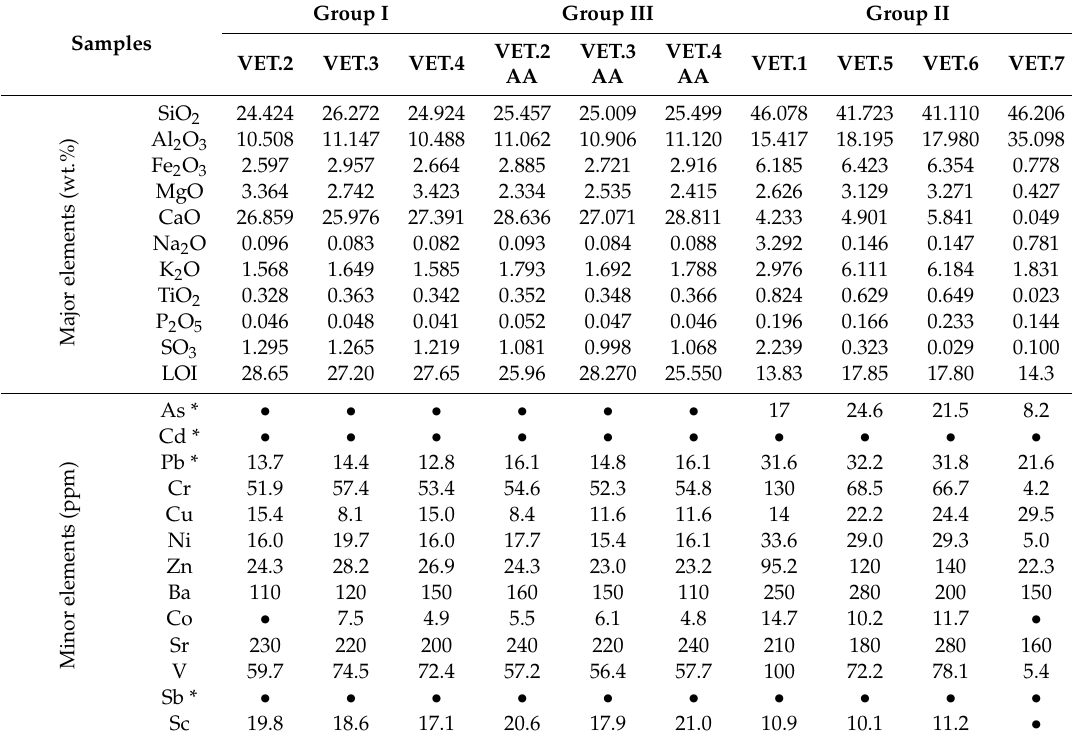
Table 3. Major and minor element composition of the samples. LOI = loss on